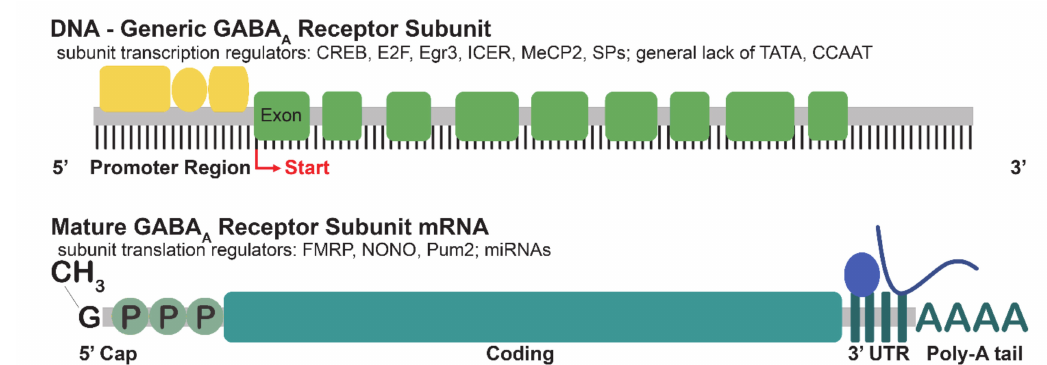
Figure 2. Overview of the major regulators of transcription and translation influencing the expression of GABA A R subunits. Generally, the 5 (cid:48) UTR of GABA A R subunit genes contains multiple consensus sites for transcription factors (yellow), and in many cases, multiple transcription start sites (red). The majority of subunits lack canonical TATA and CCAAT sequences in their 5 (cid:48) UTRs. A number of MeCP2. Maturation of the mRNA involves the addition of a 5 (cid:48) cap as well as a poly-A tail adjacent to the 3 (cid:48) UTR. Mature GABA A R transcripts are transported out of the nucleus to ribosomes on the rough endoplasmic reticulum, where translation is influenced by RNA-binding proteins (blue oval) such